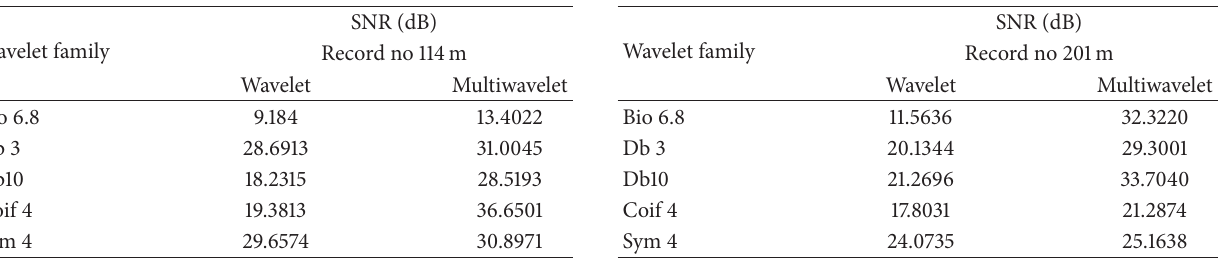
Table 4: Performance comparison of wavelet and multiwavelet for record